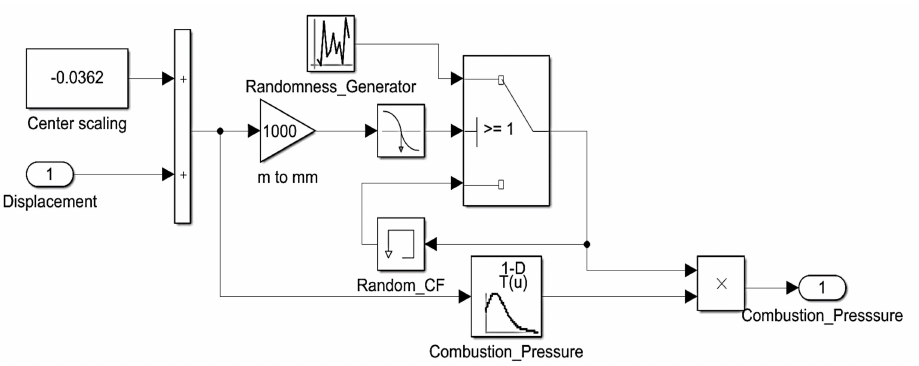
Figure 14. Simulink code to implement cycle-to-cycle combustion